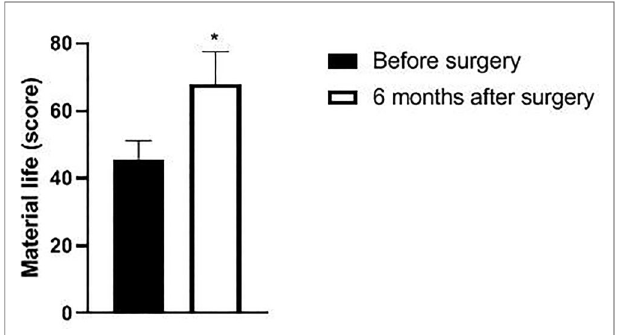
FIGURE 7 | Changes in material life scores of patients before and after surgery.